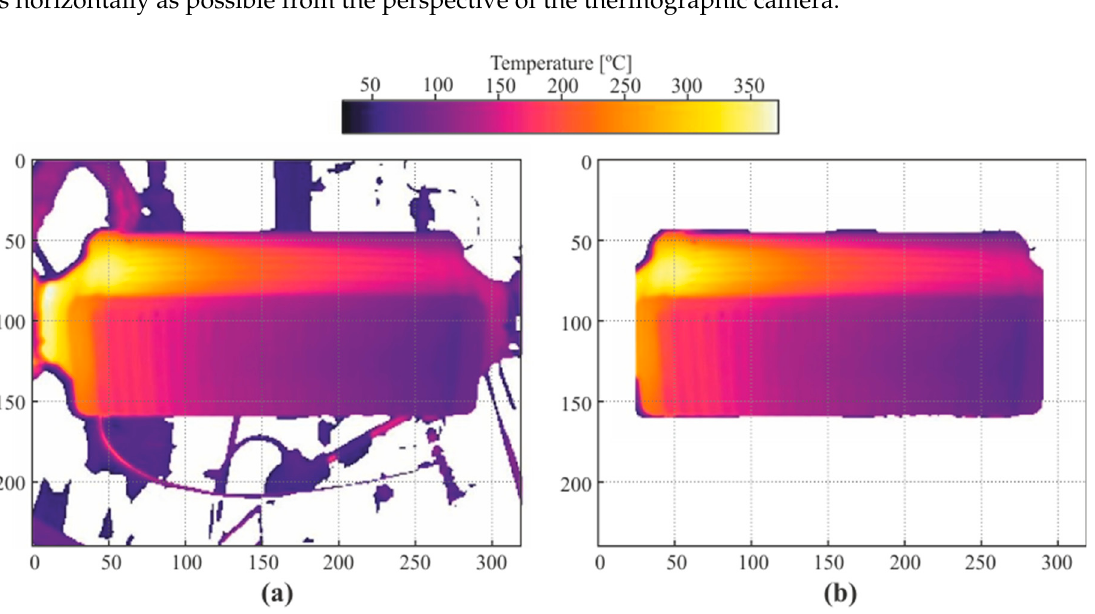
Figure 5. ( a ) Sample of the core of the boiler detected. ( b ) Sample of thermography after filtering cold pixels in the background.